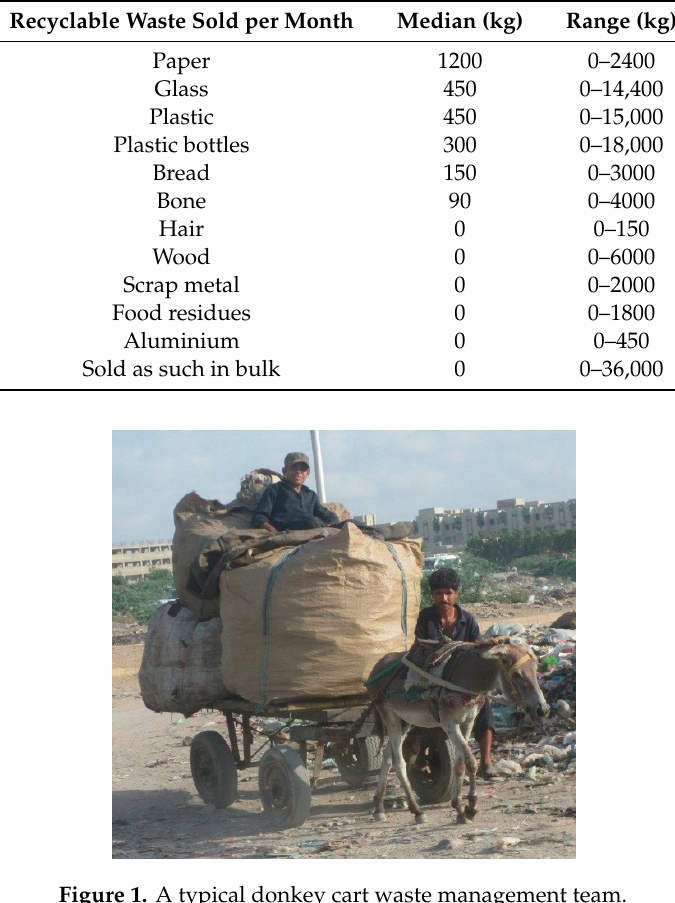
Table 3. Item-wise monthly sale per household of recyclable waste in kilograms.